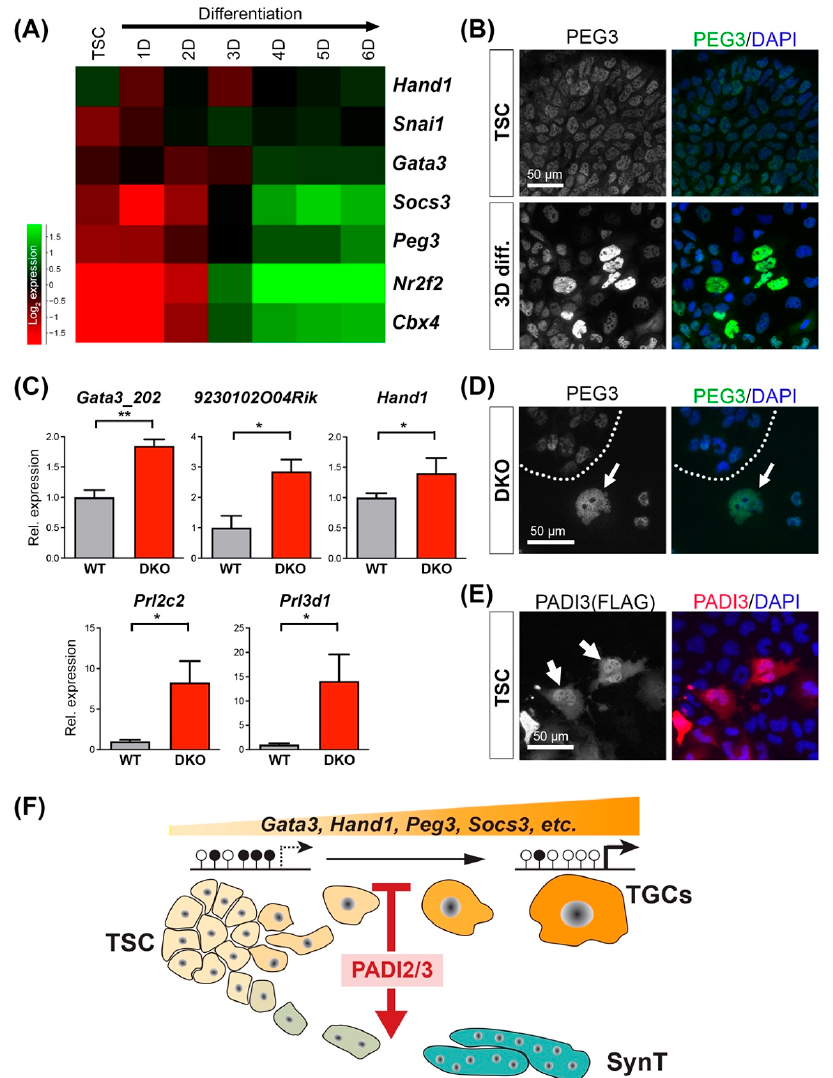
Figure 5. CGI hypomethylation licenses trophoblast differentiation-promoting genes for precocious up-regulation. ( A ) Expression dynamics of trophoblast differentiation-relevant genes that are as- sociated with hypomethylated CGIs in Padi2/3 DKO cells across a TSC differentiation time course. ( B ) Immunofluorescence staining for PEG3 indicates its up-regulation in TSCs after 3 days of differ- entiation. ( C ) RT-qPCR analysis showing the up-regulation of genes associated with hypomethylated CGIs ( Gata3_202 , 9230102O04Rik , Hand1 ) and TGC differentiation markers ( Prl2c2 , Prl3d1 ) in Padi2/3 DKO TSCs under stem cell conditions. Data are expressed relative to WT TSCs and are displayed as the mean +/ − S.E.M. Statistical analysis by unpaired Student’s t -test (* p < 0.05; ** p < 0.01; n = 4 independent clones per genotype). ( D ) Immunofluorescence staining for PEG3 showing stronger expression in the enlarged TGCs (arrow) that are evident in Padid2/3 DKO TSCs under stem cell conditions. ( E ) Immunostaining for FLAG-tagged PADI3 in TSCs revealing unequivocally nuclear localization (arrows) in TSCs. ( F ) Model depicting the role of PADI2/3 in TSCs. Both PADIs act synergistically to prevent precocious TGC differentiation by maintaining DNA methylation at CGIs that are associated with key trophoblast genes, preventing their premature up-regulation. This inhibitory effect towards TGC formation allows for the sufficient differentiation of SynT